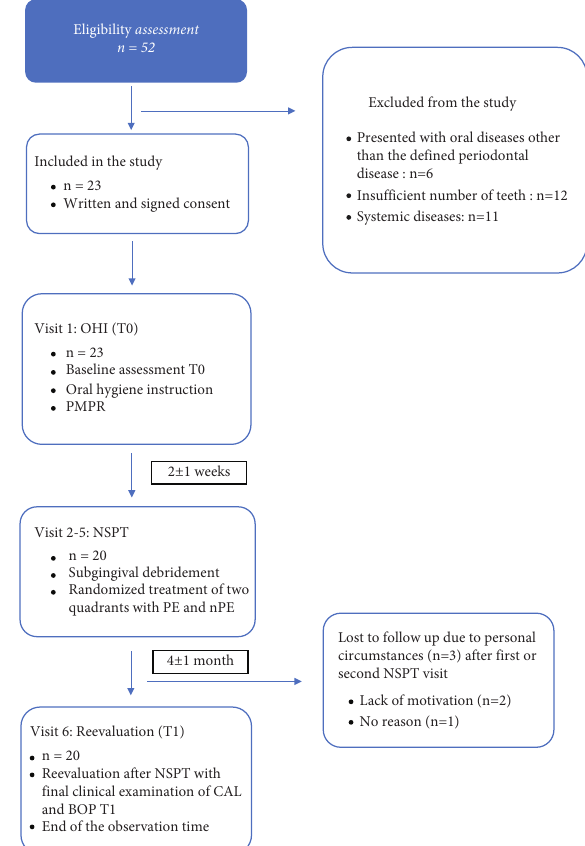
Figure 1: Flowchart of the patients’ recruitment and treatment protocol during the study. T 0: initial treatment visit, T 1: reeval- uation after the treatment phase of nonsurgical periodontitis therapy (NSPT), either quadrant treatment with periodontal en- doscopy (PE) or quadrant treatment without periodontal endos- copy ( n PE) in terms of bleeding on probing (BOP); clinical attachment level (CAL), hygiene instruction (OHI), and supra- gingival professional mechanical plaque removal